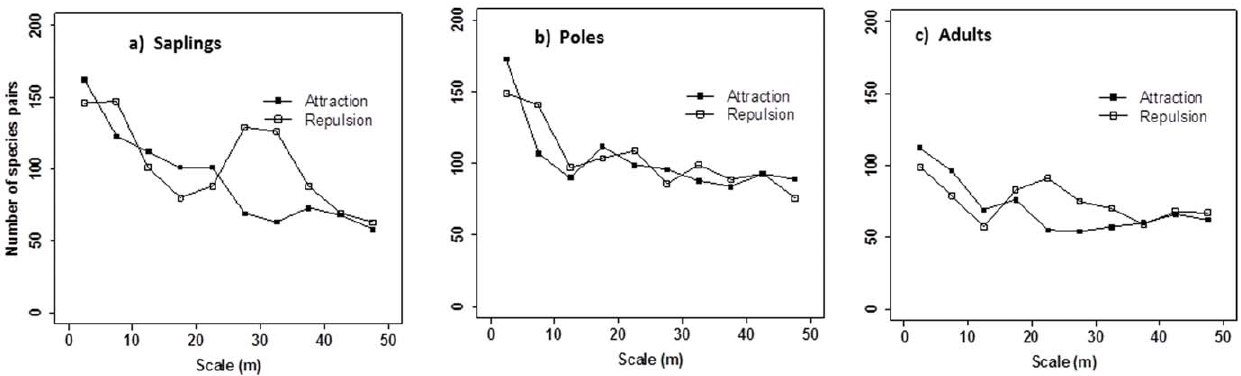
Figure 4. Number of significant attraction and repulsion for all species at the three life stages at scales 0–50 m. a) saplings, b) poles, c) adults.